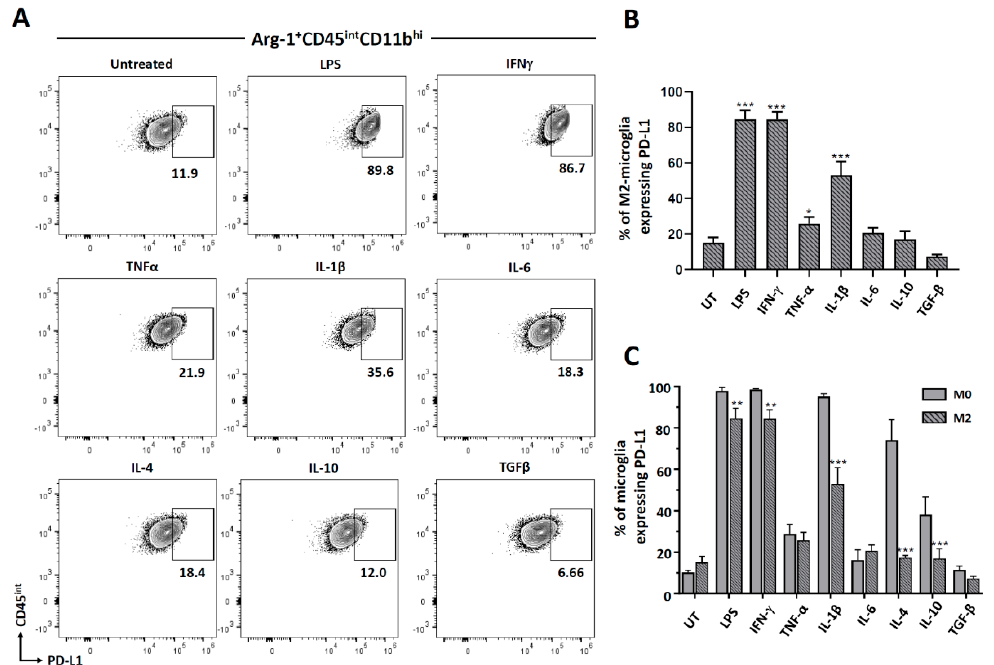
Figure 5. PD-L1 expression on M2-polarized microglial cells. Microglia were isolated as described previously and then treated with IL-4 to polarize them to an M2-activated state. These M2-polarized cells were subsequently treated with select pro- as well as anti-inflammatory cytokines and then analyzed for the expression of PD-L1. ( A ) Representative contour plots showing M2-polarized cells (Arg-1 + CD45 int CD11b hi ) expressing PD-L1. ( B ) Graphical representation of M2-polarized microglia expressing PD-L1 after 24 h of treatment. ( C ) Graphical representation comparing PD-L1 expression between non-polarized (M0) and M2-polarized microglia after 24 h of treatment. UT-untreated control. Experiments were carried out three times with duplicate wells. * p < 0.05; ** p < 0.01; *** p < 0.001.